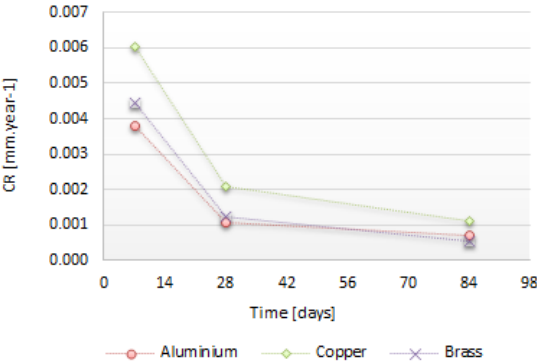
Figure 2. Comparison of the dependence of CR value (in mg year − 1 ) of metals in Rubitherm SP25 (inorganic PCM).